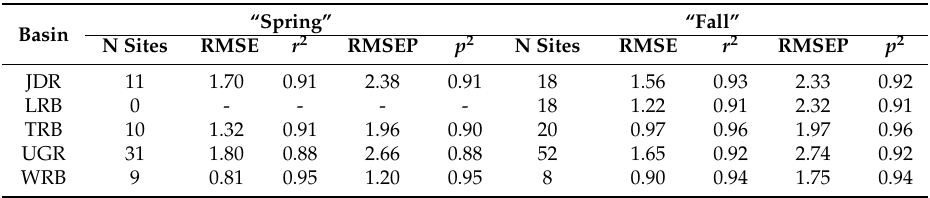
Figure 9. Eight-day mean stream temperature predicted vs. observed for the leave-one-out validation data for all basins. The solid black line is the simple linear regression between the predicted and observed temperatures (with r 2 for that relationship). The dashed line is the one-to-one relationship. RMSE = 1.29 °C. Table 5. Model metrics for eight-day models for all basins. RMSEP and p 2 are from leave-one-out cross validation. JDR = John Day River, LRB = Lemhi River, TRB = Tucannon River, UGR = Upper Grande Ronde, WRB = Wenatchee